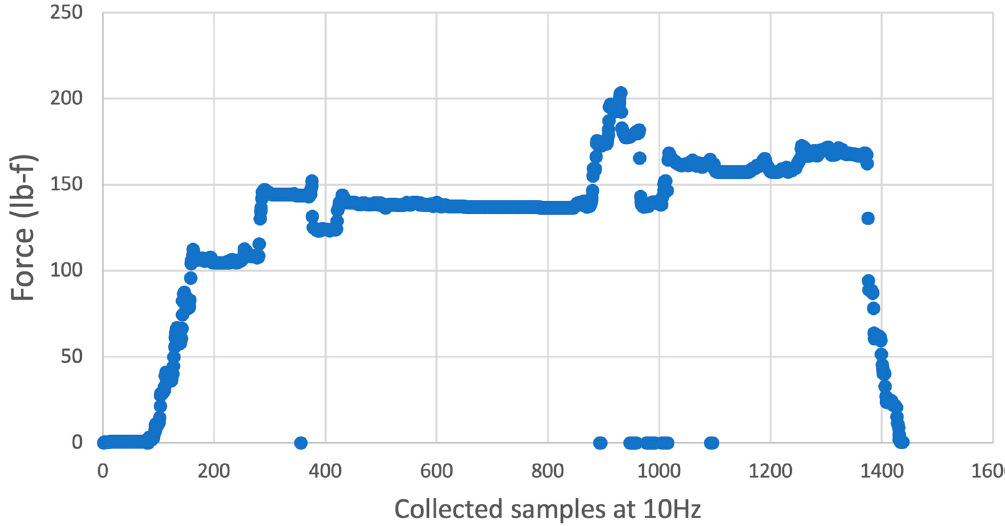
Figure 5. Maximum force output of planetary roller screw actuated by hand. Samples captured every 0.1 s.